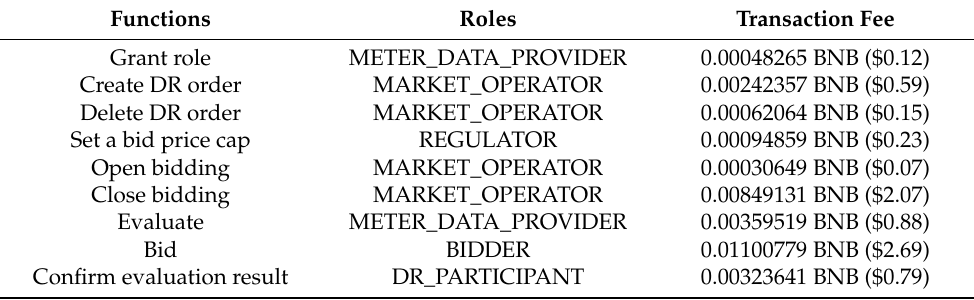
Table 6. Costs of smart contract